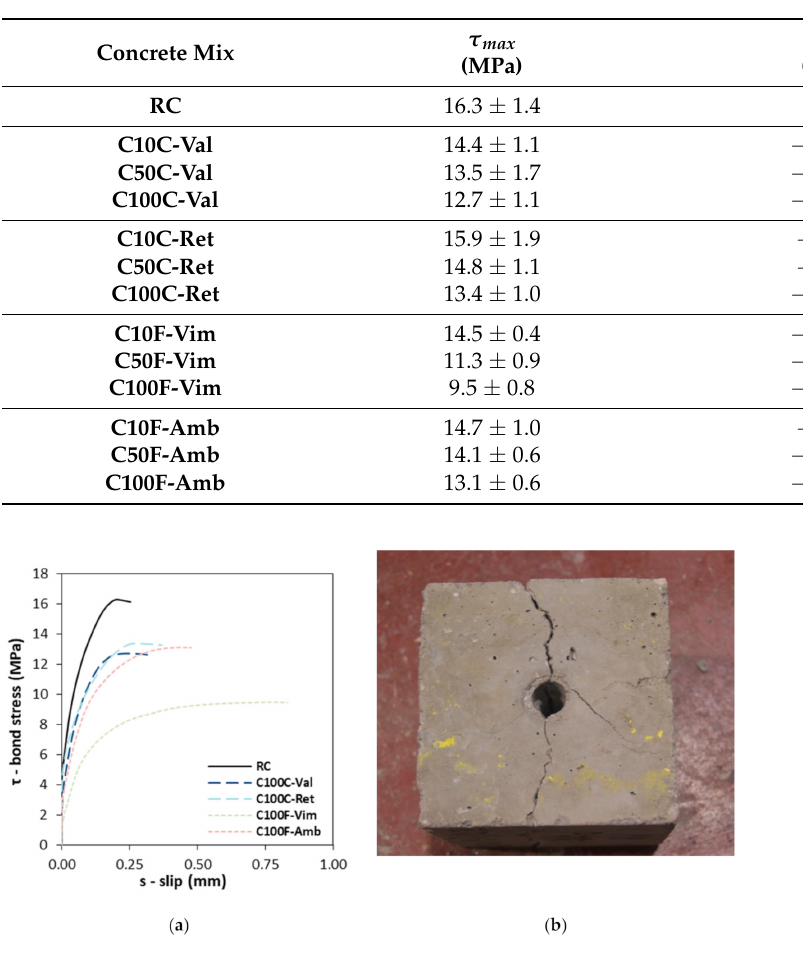
Figure 1. ( a ) Bond stress vs. slip curves and ( b ) failure mode of